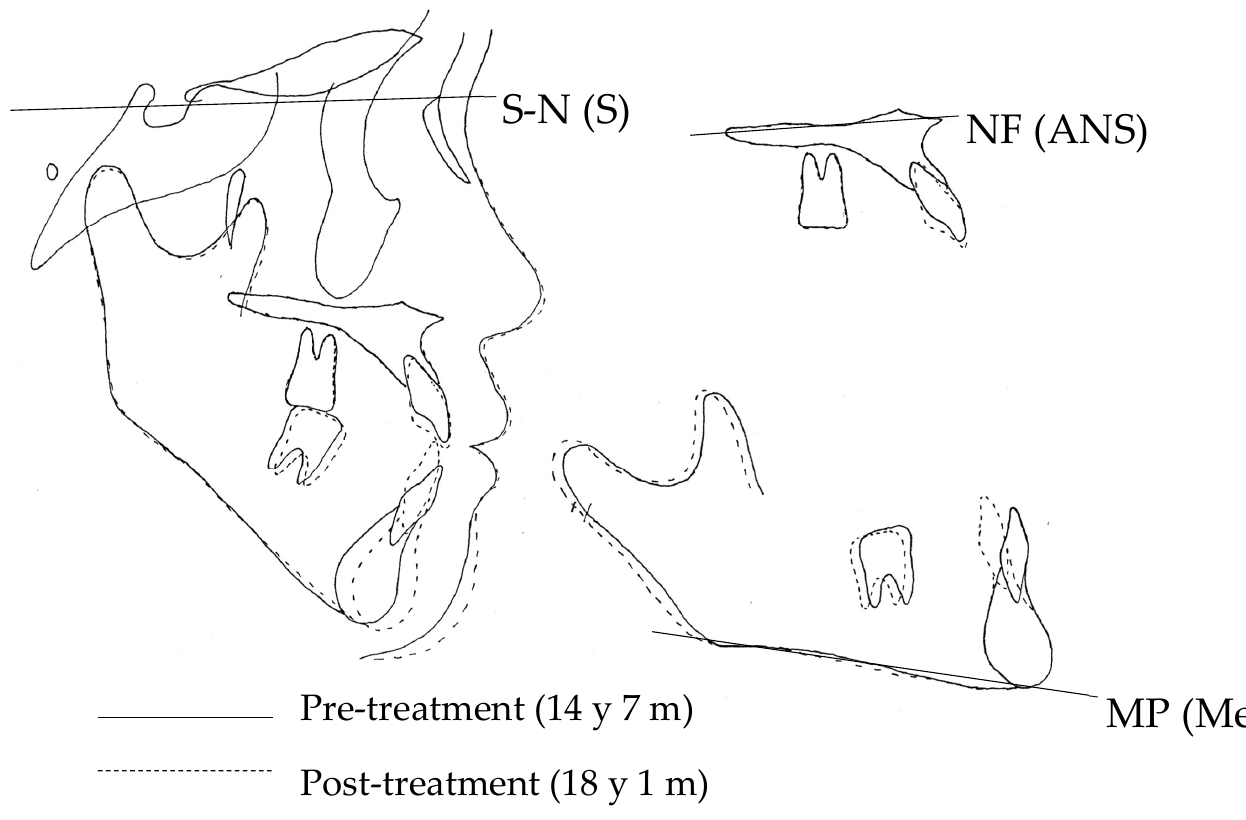
Figure 13. Lateral cephalometric superimposition. S-N (S): Superimposition on sella-nasion at sella; MP (Me): superimposition on the mandibular plane at menton; NF (ANS): superimposition on the nasal floor at anterior nasal spine.